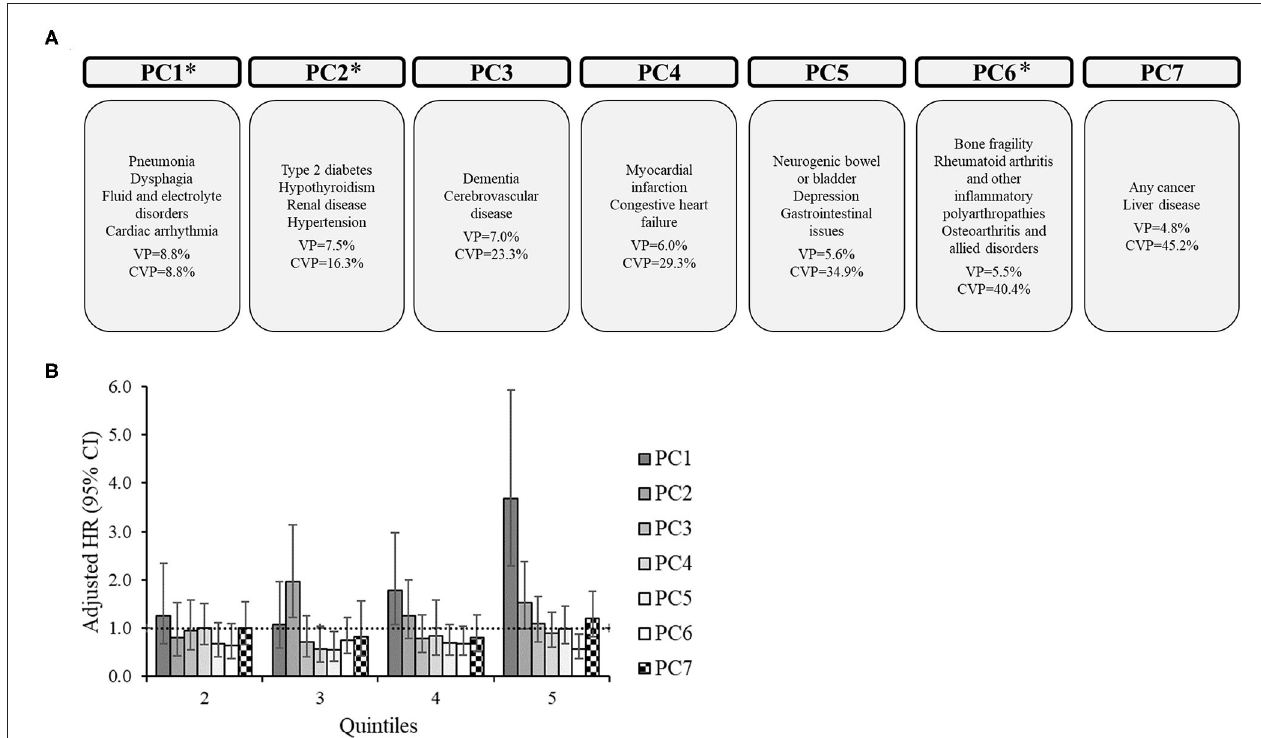
FIGURE 3 | Principal component analysis among 2,607 adults with cerebral palsy with co-occurring epilepsy, but without co-occurring intellectual disabilities. (A) Principal components (PC) represent the comorbidity combinations in order of the amount of variance percent (VP) explained and the cumulative VP (CVP) explained. * P < 0.05 for the association of that PC with 2-year mortality. (B) The association between each PC with 2-year mortality after PC scores were transformed into quintiles to facilitate comparisons across PCs (reference: lowest quintile). The bars represent the hazard ratio (HR) and the vertical lines represent the 95% confidence interval (CI) for 2-year mortality after adjusting for all PCs, age, sex, race, and U.S. region of residence. The dotted horizontal line represents a HR of 1.0. If the 95% CI crosses the dotted line, the association is not statistically significant at P =